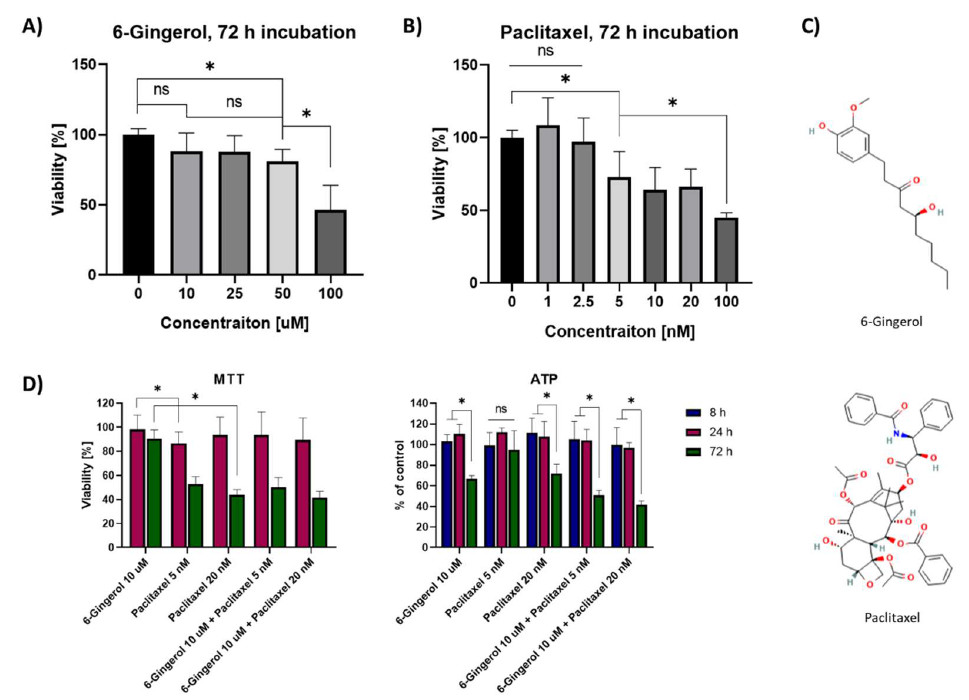
Figure 1. MTT viability assay 72 h after incubation with ( A ) 6-Gingerol and ( B ) Paclitaxel in concen- trations ranging from 0 to 100 µM and from 0 to 100 nM, respectively. ( C ) Structures of 6-Gingerol and Paclitaxel; ( D ) MTT and ATP assays after a combination of 6-Gingerol with 5 nM and 20 nM Paclitaxel assessed after 8, 24 and 72 h, * p < 0.05 in the Kruskal–Wallis test for ( A , B ) or ANOVA test for ( D ); ns—not statistically significant.